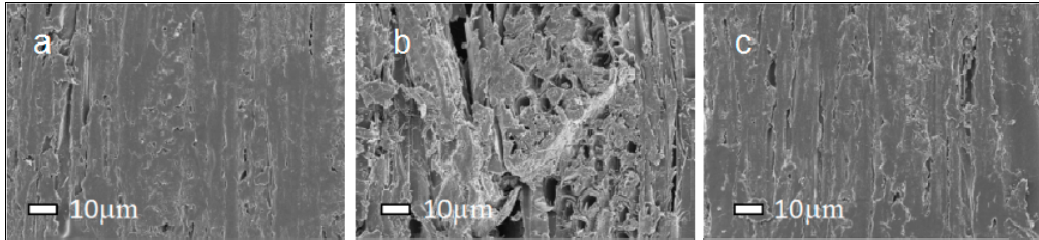
Figure 4. Scanning Electron Microscopy (SEM) images of thermo-treated cherry wood: ( a ) untreated, ( b ) nitrogen plasma treated, and ( c ) oxygen plasma treated.